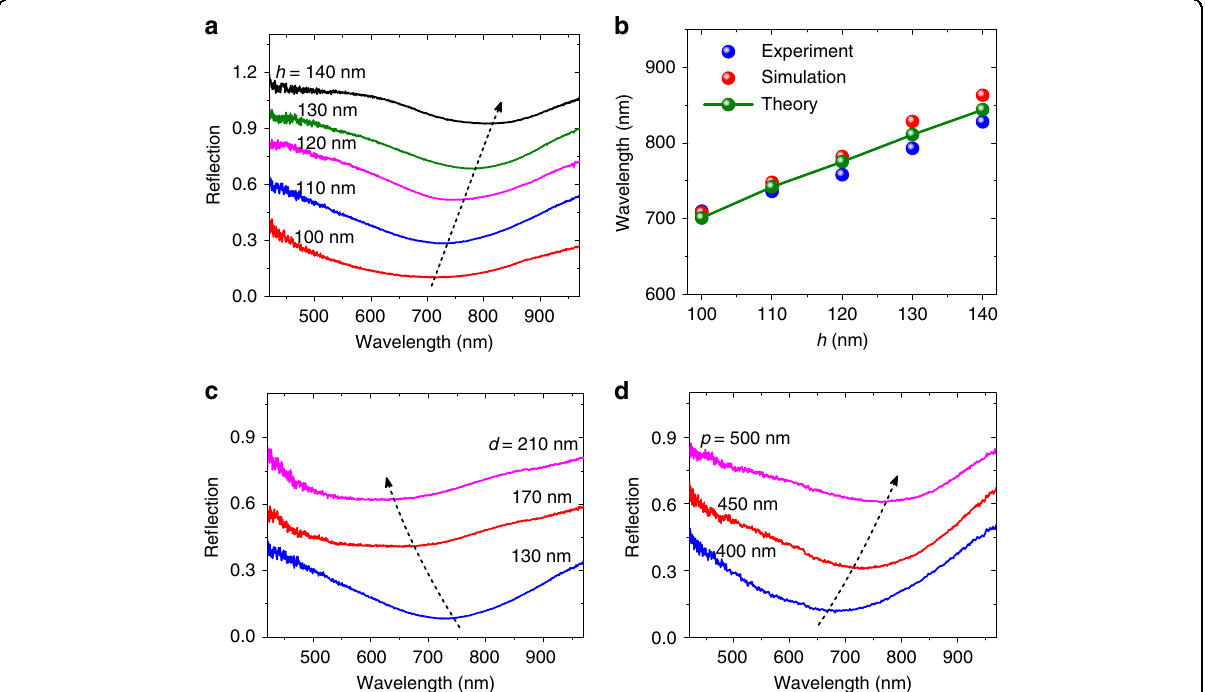
Fig. 3 Measured MPR spectral response of TI nanogrooves with different structural parameters. a Experimentally measured re fl ection spectra from the Sb 2 Te 3 nanogroove grating with different heights h = 100, 110, 120, 130, and 140 nm when d = 130 nm, p = 450 nm, and θ = 0°. b Corresponding MPR wavelengths of Sb 2 Te 3 nanogrooves with different h . The experimental, simulation, and theoretical results are obtained by the micro-spectrometer, FDTD method, and MLC circuit model, respectively. c , d Experimentally measured re fl ection spectra from the Sb 2 Te 3 nanogroove grating with different widths d = 130, 170, and 210 nm, when h = 110 nm, p = 450 nm, and θ = 0° and with different pitches p = 400, 450, and 500 nm, when h = 120 nm, d = 170 nm, and θ =